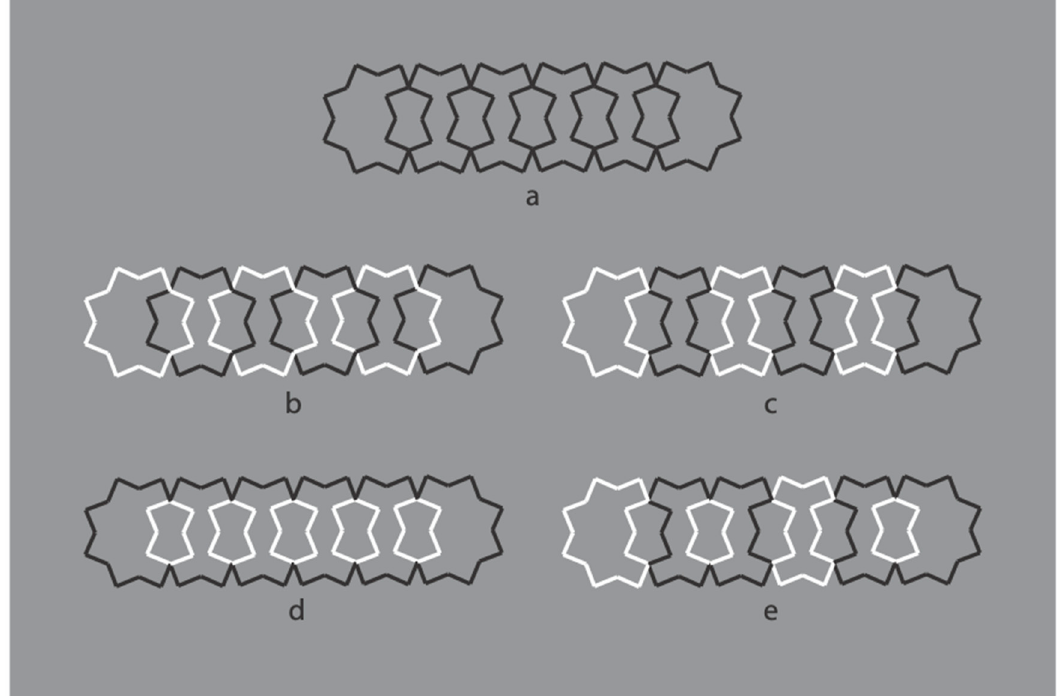
Figure 7. New complex results by overlapping six eight-pointed stars.